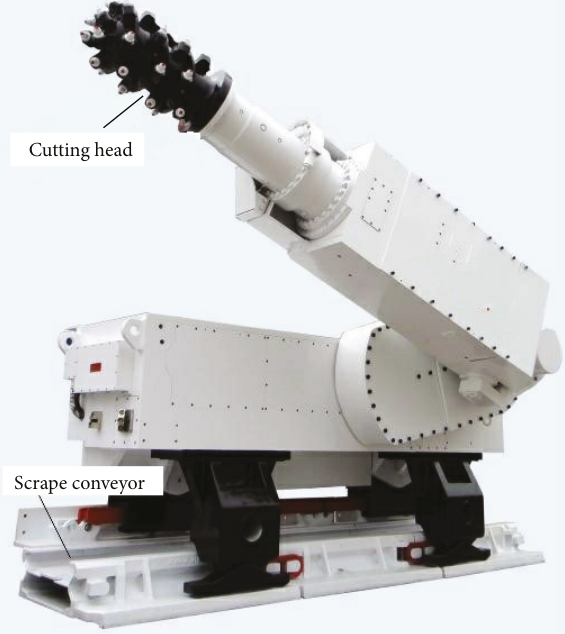
Figure 3: Field schematic diagrams of the new roadheader-assisted coal cutter.